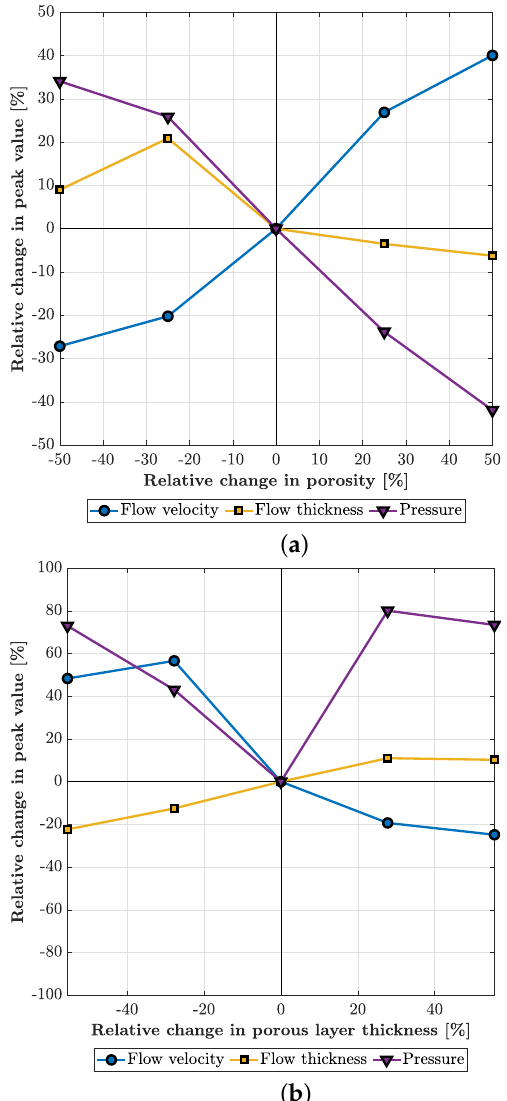
Figure 11. ( a ) Relative change in porosity n [%] compared to the default n = 0.4. The peak values are based on the time series between 290 and 310s and compared to the default peak values using n = 0.4. ( b ) Relative change in porous layer thickness η [%] compared to the default 36mm. The peak values are based on the time series between 290 and 310s compared to the default peak values using η =